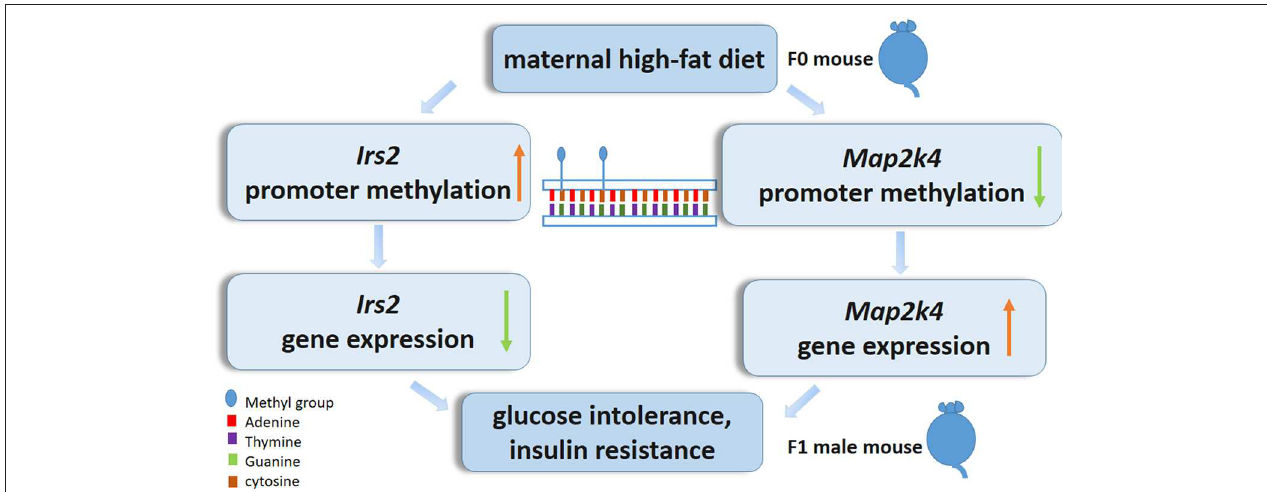
FIGURE 7 | Epigenetic mechanism of high-fat diet in utero and adult on offspring. In utero expose to high-fat diet modify Irs2 and Map2k4 gene methylation and gene expression in offspring, led glucose intolerance, and insulin resistance.